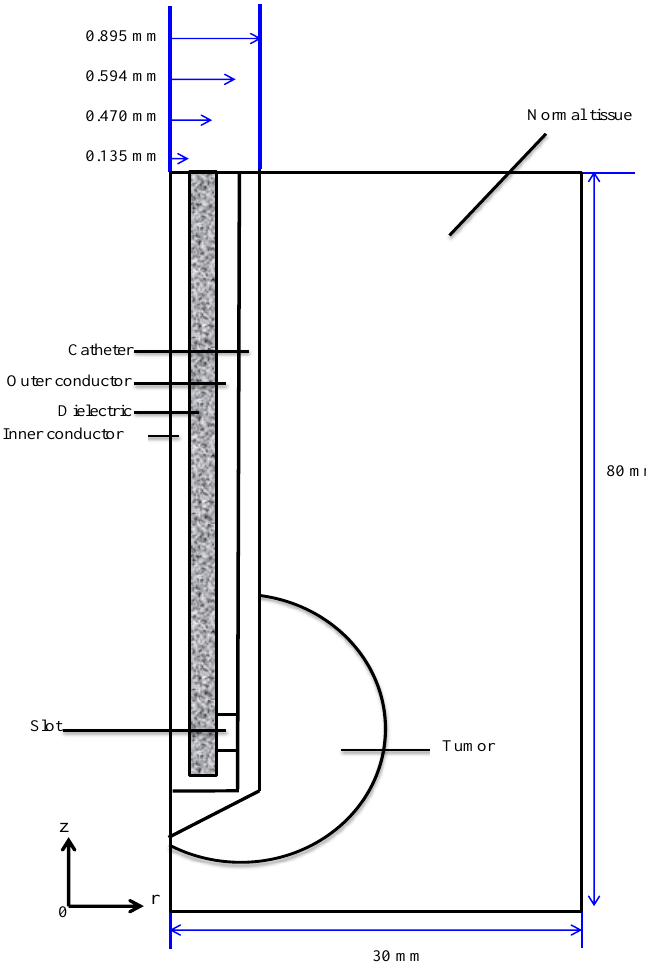
Figure 3. Axial schema of the micro-coaxial antenna inserted in biological tissue.